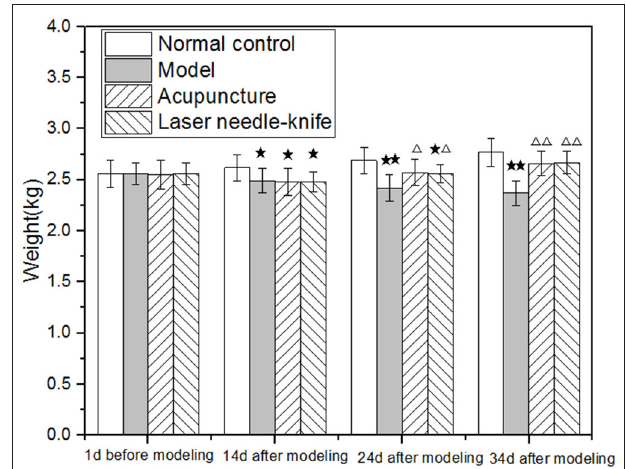
FIGURE 1 | Weight of CSA rabbits. Compared with normal control group, * P < 0.05, ** P < 0.01; Compared with model group, 1 P < 0.05, 11 P < 0.01.